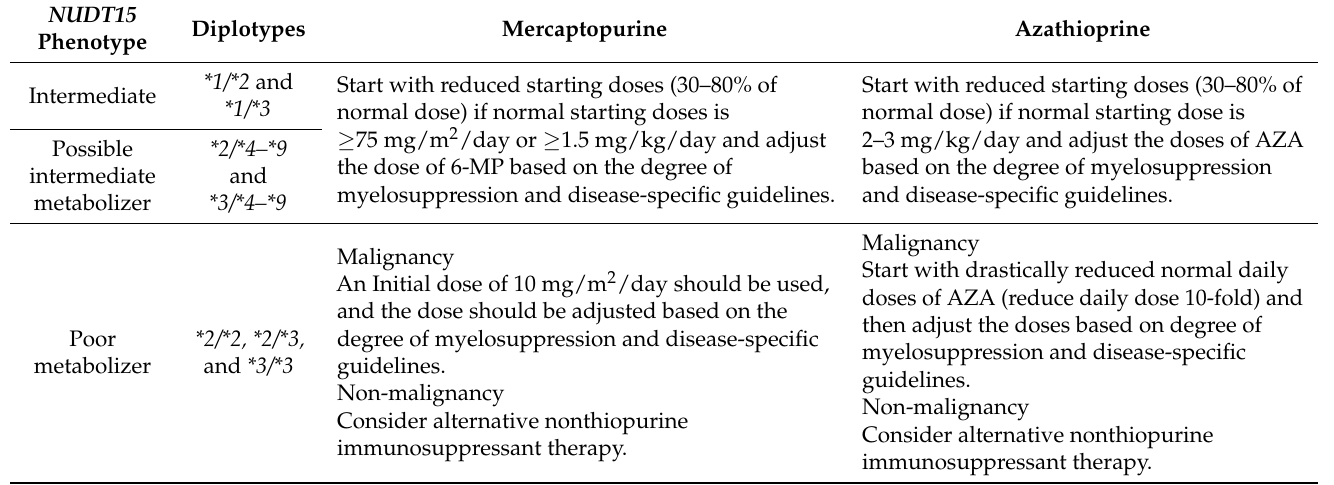
Table 2. Recommended initial treatment and dose adjustment of thiopurine therapy for NUDT15 genotype based on the CPIC